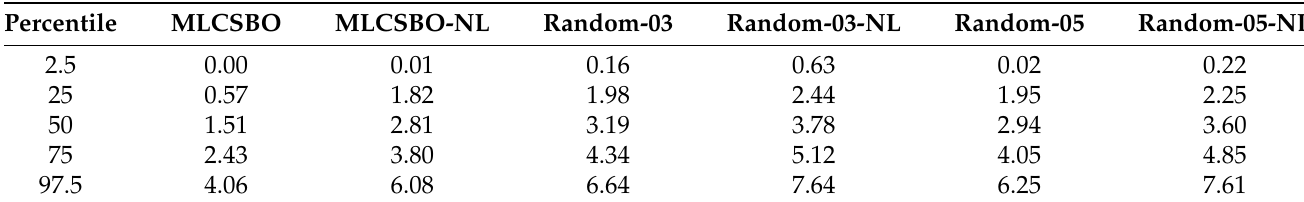
Table 4. Percentile values for MLCSBO and Random operators, with and without local search operator. Percentile